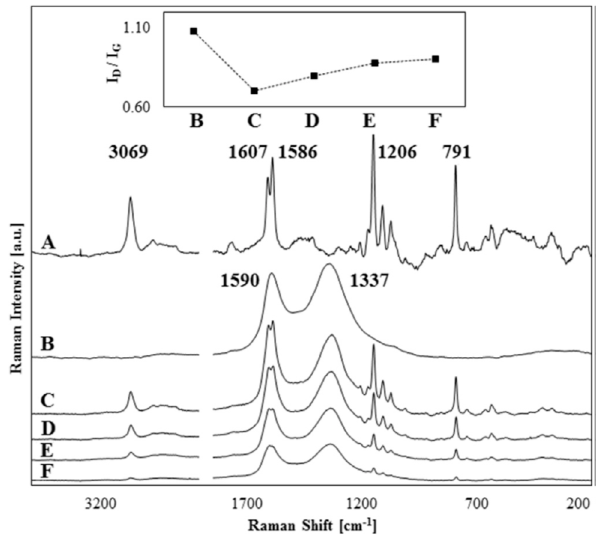
Figure 10. Raman spectra of PSF (A), G-COOH (B) and PSF / G-COOH 0.25–2 wt.% (C-F). The variation of I D / I G ratio with G-COOH concentration is represented within the inset. (Reproduced with permission after [77]).